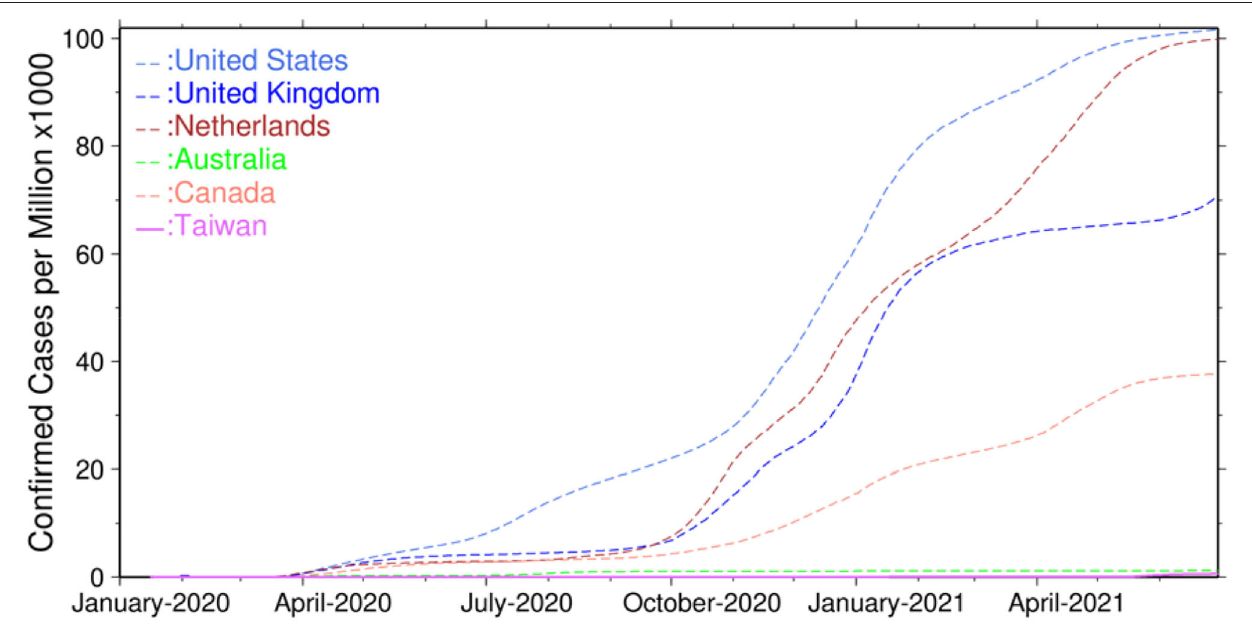
FIGURE 1 | Confirmed infections of COVID-19